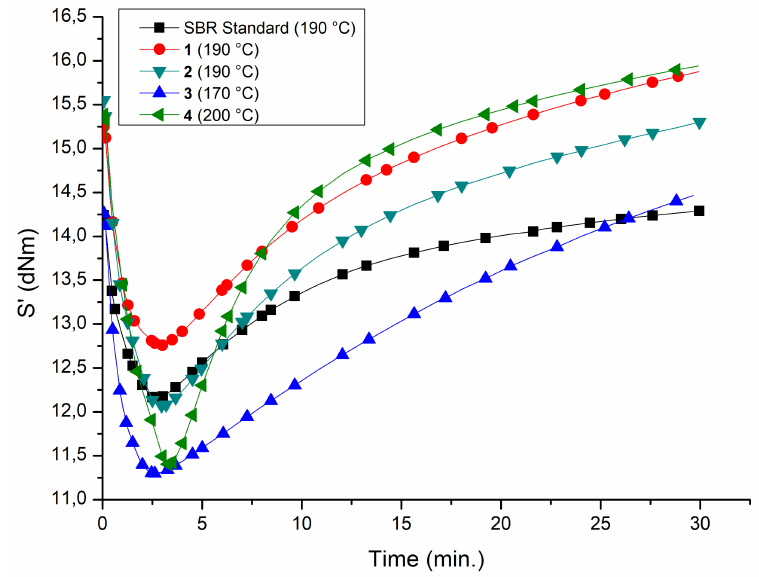
Figure 4. Torque crosslinking curves of final